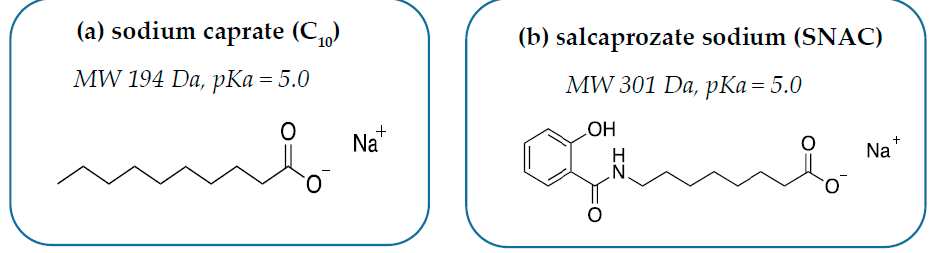
Figure 1. Structures of ( a ) sodium caprate (C 10 ) and ( b ) salcaprozate sodium